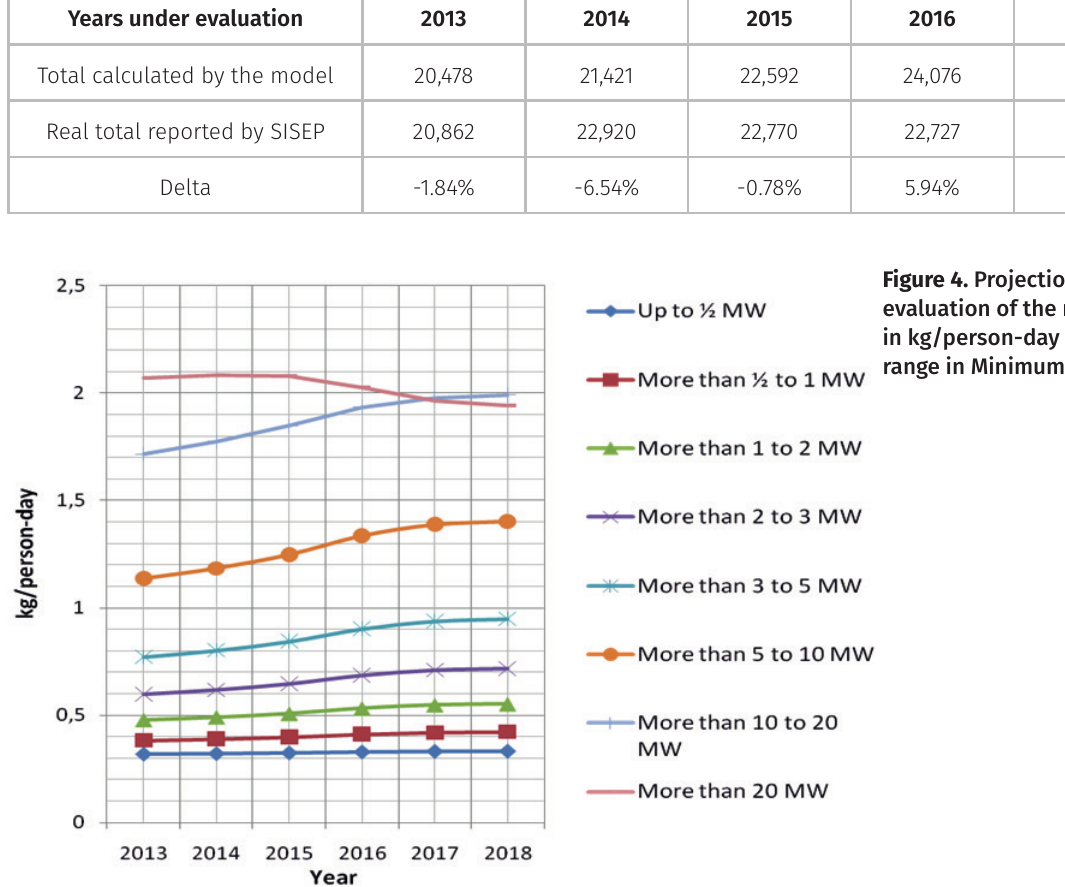
Table I. Evaluation of the model by the annual average of HSW generation in Metric tons/month. Years under evaluation